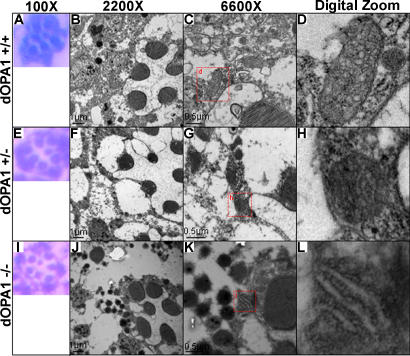
The dOpa1 Mutation Affects Mitochondrial Morphology and Tissue IntegrityWhole flies were sectioned and analyzed by hematoxylin and eosin (H&E) staining and standard microscopy (A), (E), (I) or TEM (B–D), (F–H), (J–L). (C), (G), and (H) contain red boxes with d, g, and i in them, respectively, indicating the region digitally zoomed in (D), (H), and (I). As shown in (A–C), there are no differences in the number of rhabdomeres among dOpa1
+/+ (A), dOpa1
+/in3 (E), and dOpa1
in3/in3 (I) ommatidial units (n > 40). Note: TEM analysis of similar sections revealed a significant difference in mitochondrial morphology along with abnormalities in the cells surrounding the rhabdomeres. dOpa1
+/+ ommatidial units contained many mitochondria (B–D). dOpa1
+/in3 ommatidial units contained fragmented mitochondria (F–H). dOpa1
in3/in3 ommatidial units had few mitochondria (J–L), which all had very perturbed morphology. Severe tissue damage is visible in regions within dOpa1
in3/in3 ommatidial units. dOpa1
in3/in3 ommatidial units were classified based on the morphology (number of sides) of the ommatidial units; we had previously observed that dOpa1
in3/in3 ommatidial units adjacent to other dOpa1
in3/in3 ommatidial units had four rather than normal six sides.